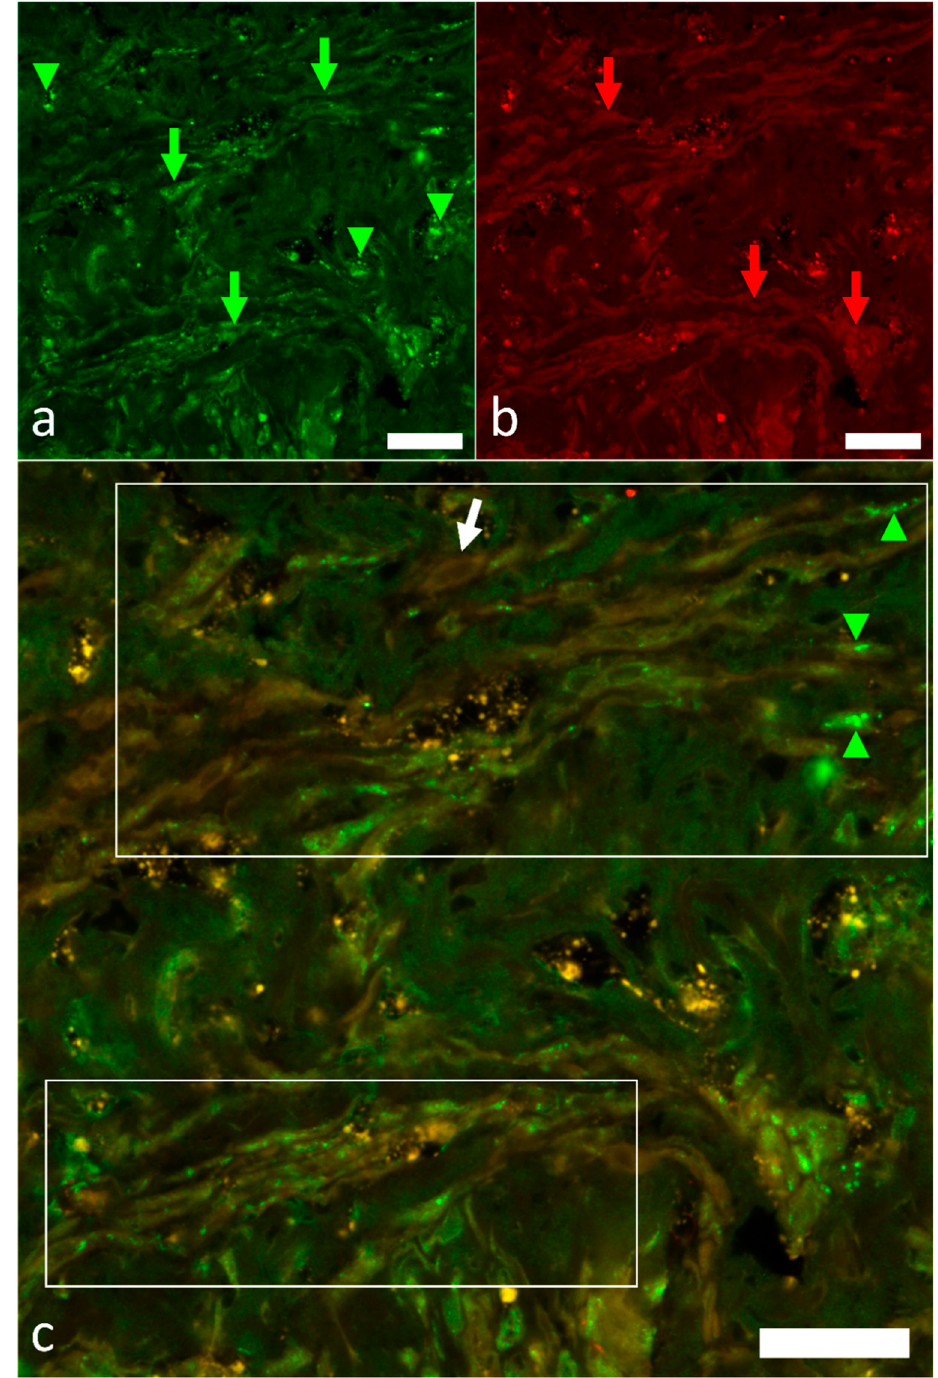
Figure 7. Double immunolabeling with antibodies against Hu (( a ), green signal and arrows) and HCN4 (( b ), red signal and arrows) in the SAR. HCN4 was weakly expressed in the pacemaker cells (green, red, and white arrows) that appeared to be innervated by Hu-immunoreactive axons and nerve fibers (arrowheads). Areas of pacemaker tissue with abundant pacemaker cells are boxed in ( c ). Scale bars: 20 µ